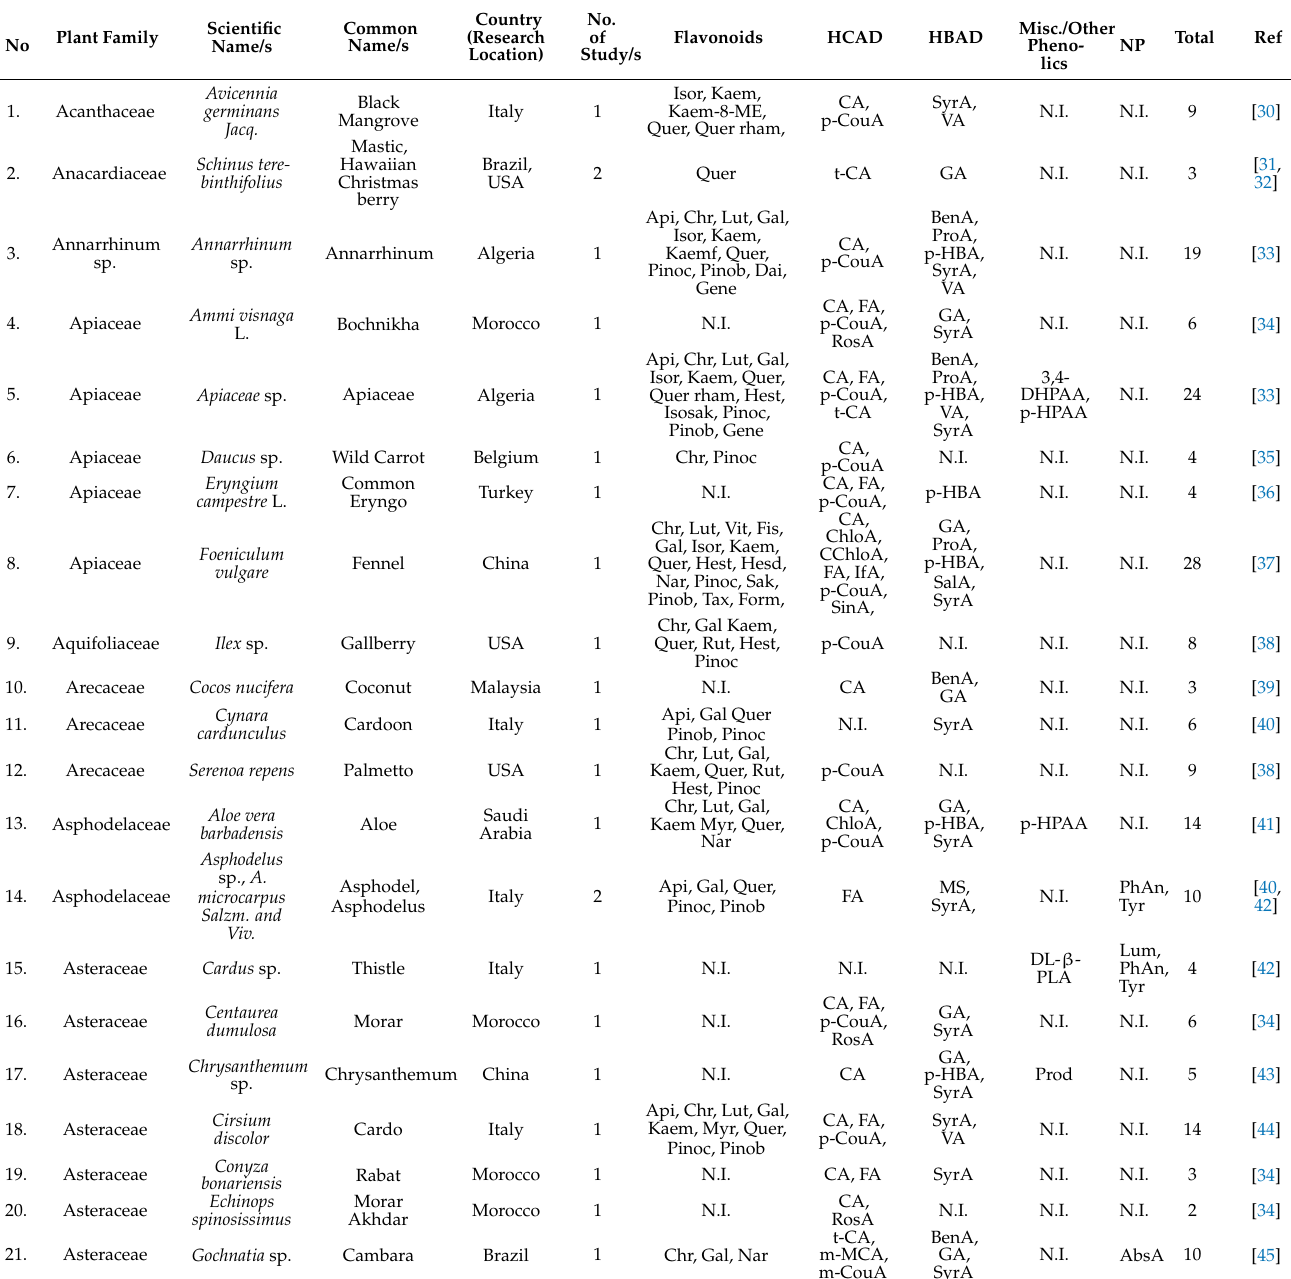
Table 1. Summary of reported phenolic and other compounds in different monofloral